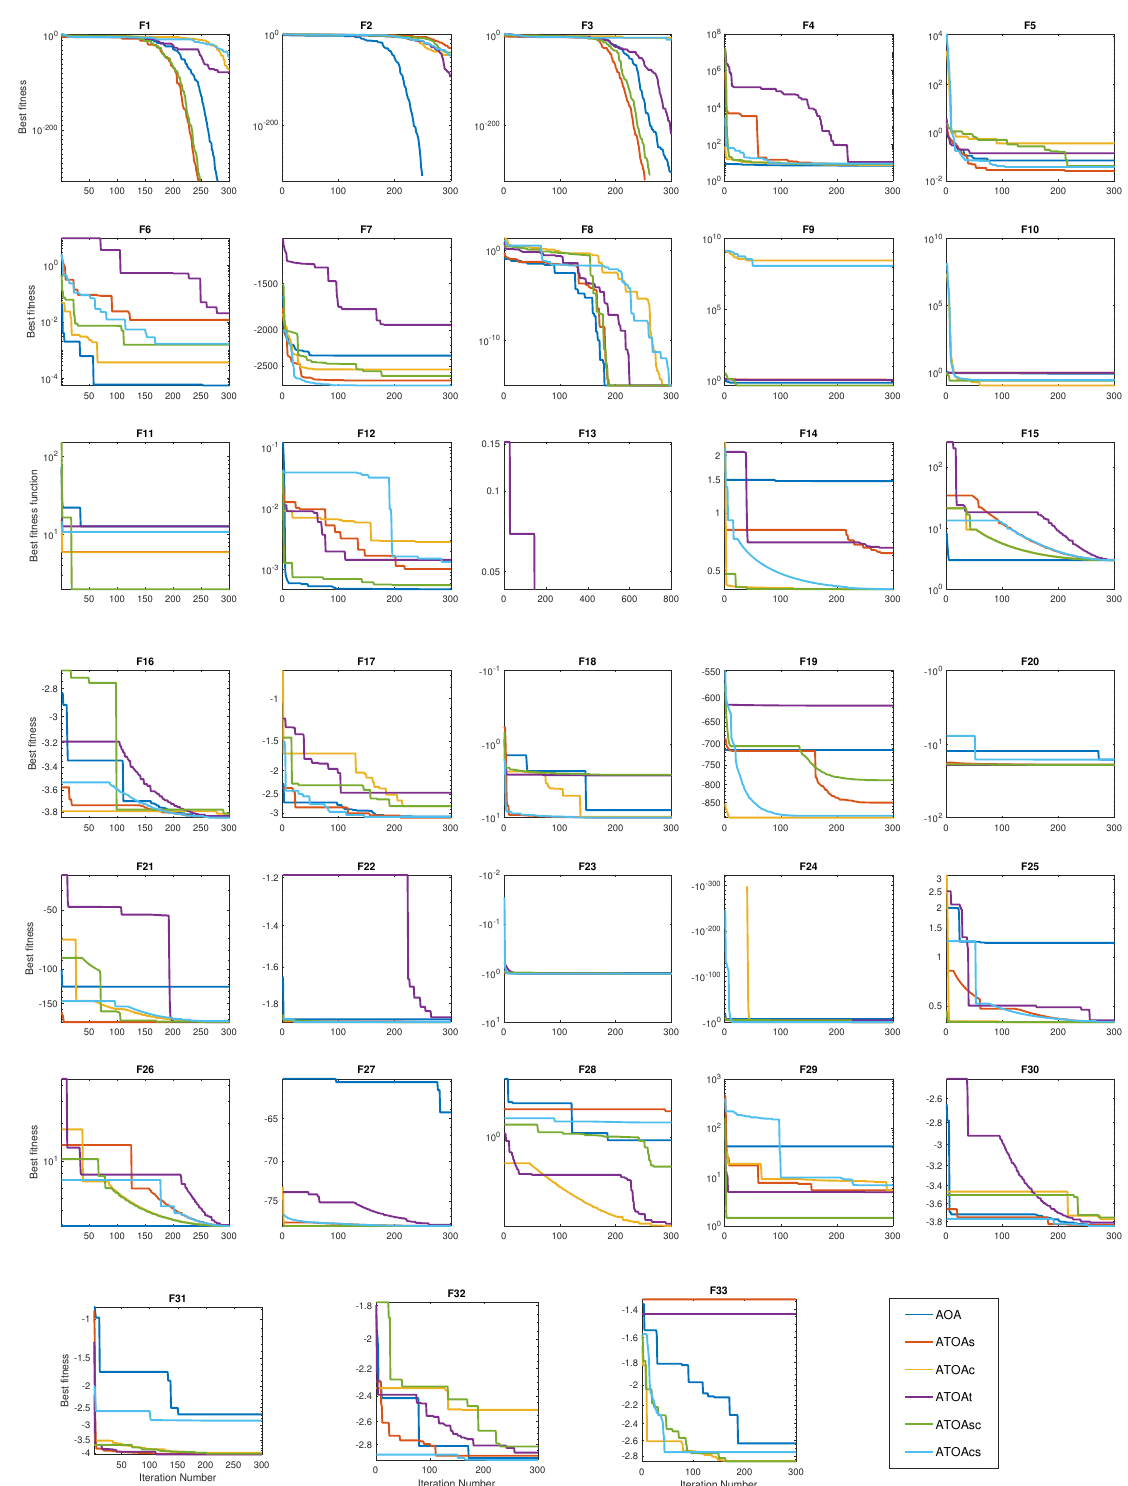
Figure 5. Convergence plots obtained from the different variants of the ATOA algorithms on various benchmark